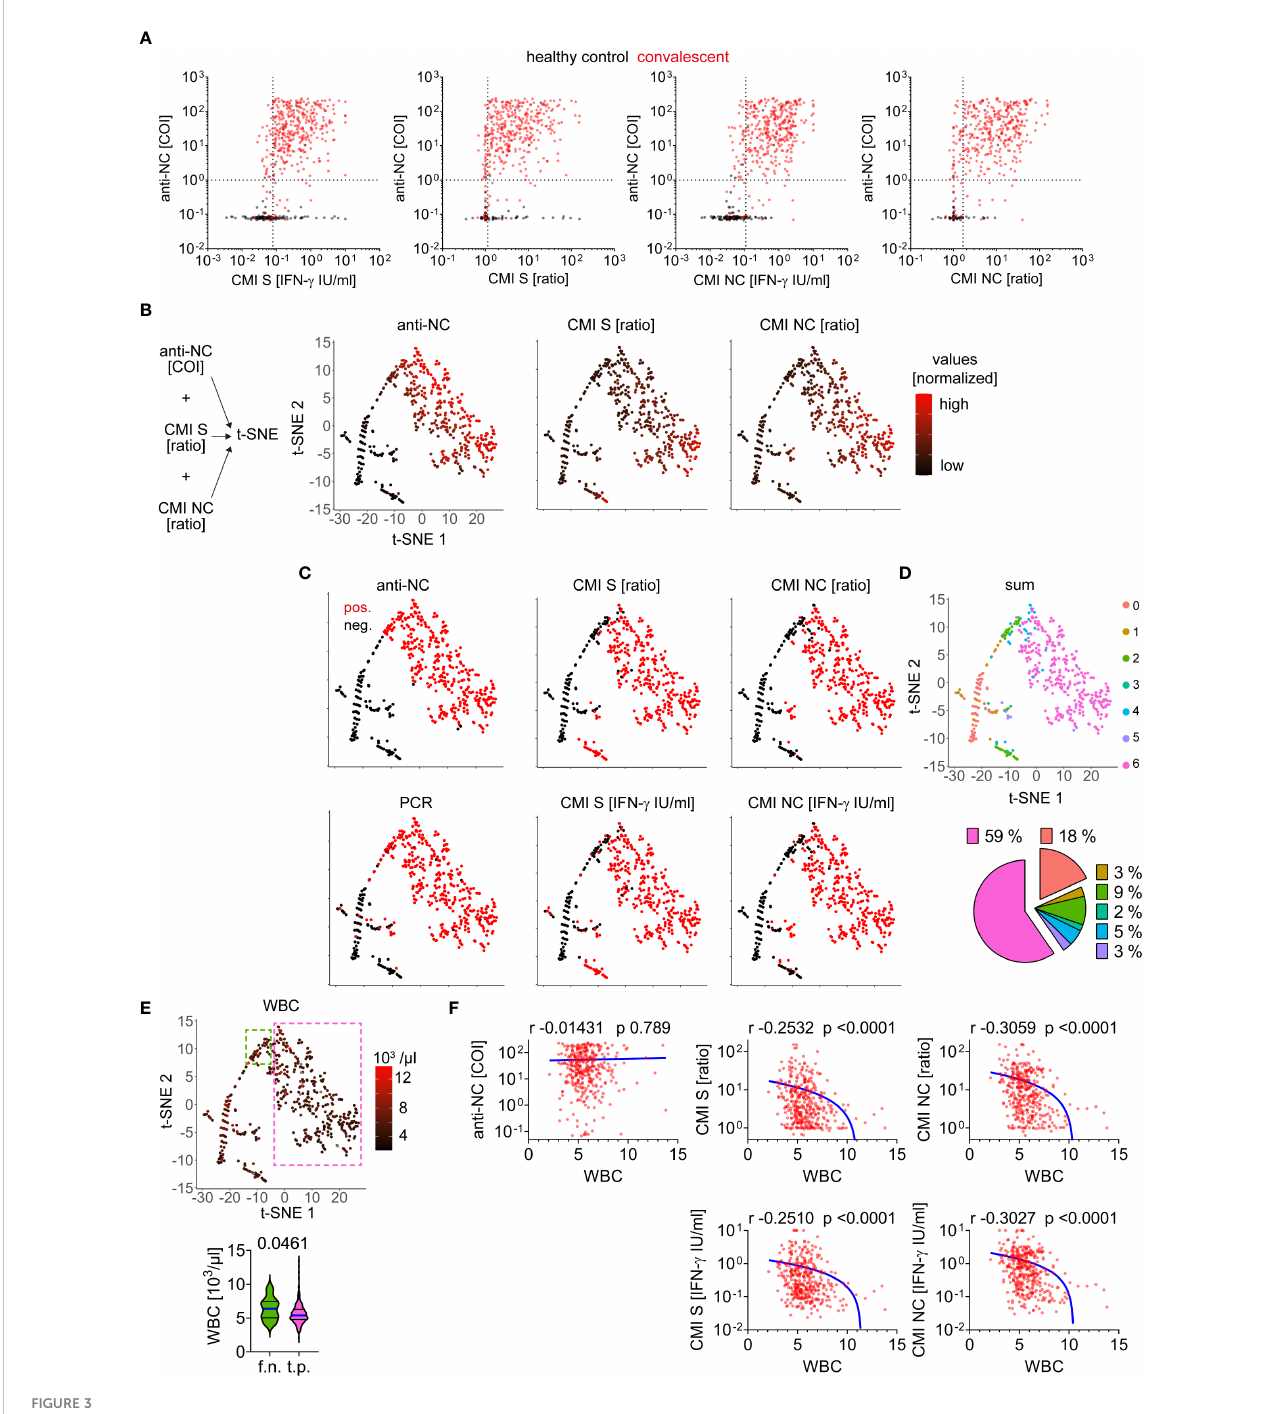
FIGURE 3 Comparative analysis of test applications for detection of SARS-CoV-2 infection (A) Absolute values measured for each CMI test and anti-NC are depicted as indicated. Dotted lines indicate cutoff values as calculated or provided by commercial manufacturer (anti-NC). (B) Data integration approach for dimensionality reduction and illustration of values (normalized) for each measured sample as indicated. (C) Test result as positive (pos.) or negative (neg.) after evaluation using calculated or provided cutoffs for each test system as indicated. (D) Concordance between test results of anti-NC, CMI S and NC ratios as well as absolute IFN- ɣ values, and PCR by summation of each result (negative = 0 and positive = 1) and superimposition in t-SNE plot as calculated in B). The pie chart illustrates the relative distribution of 100% agreement between test results (sum of 0 = 18% or 6 = 59%) as well as discrepancies (1 to 5). (E) Absolute number of white blood cell (WBC) counts measured in individuals at the same time as acquisition of anti-SARS-CoV-2 adaptive immunity testing. Values are superimposed in t-SNE plot and samples with high test concordance (sum of 6) considered as true positive (t.p) are framed in pink whereas samples with discordance between CMI tests versus antibody and PCR test (a fraction of the group with a sum of 2) are considered as false negative (f.n.) framed in green. Absolute WBC counts for these two subgroups are provided below, differences were assessed by Mann Whitney test and p-value is provided. (F) Correlation of WBC counts versus measurements as indicated. Calculated Spearman correlation results are provided for each diagram, lines indicate simple non-linear regression